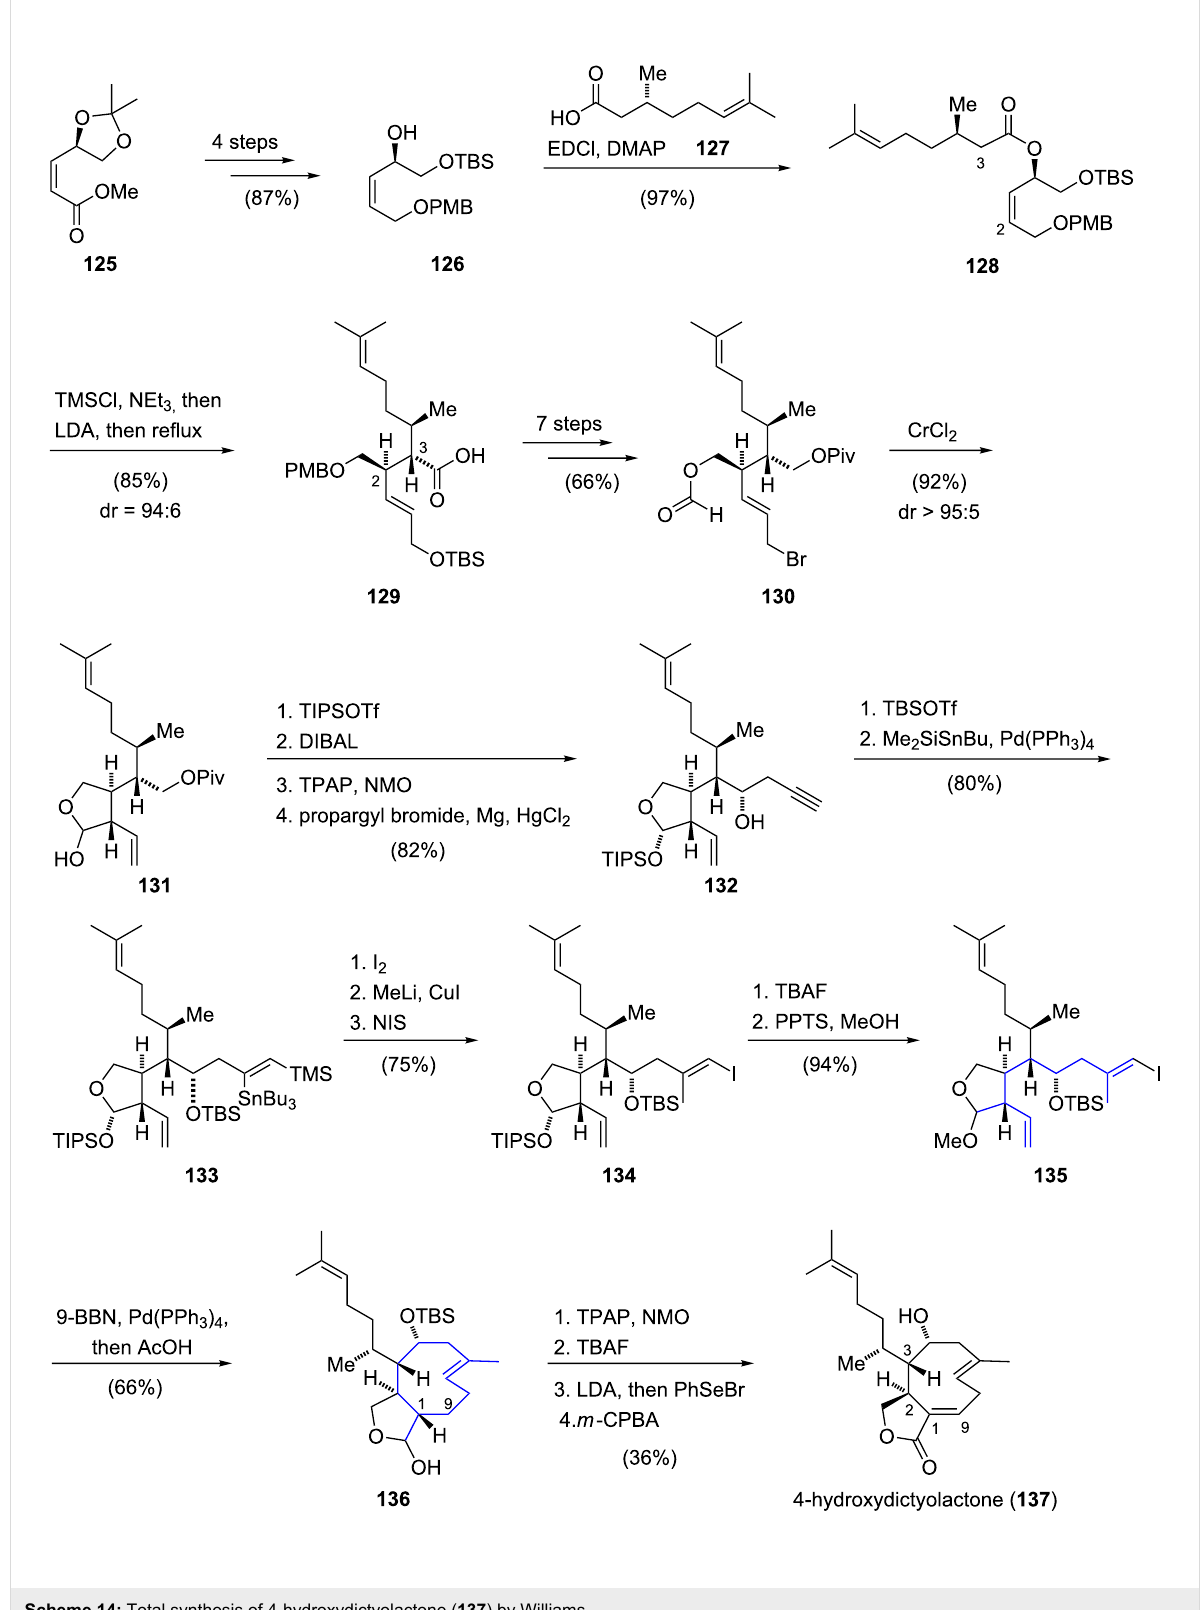
Scheme 14: Total synthesis of 4-hydroxydictyolactone ( 137 ) by